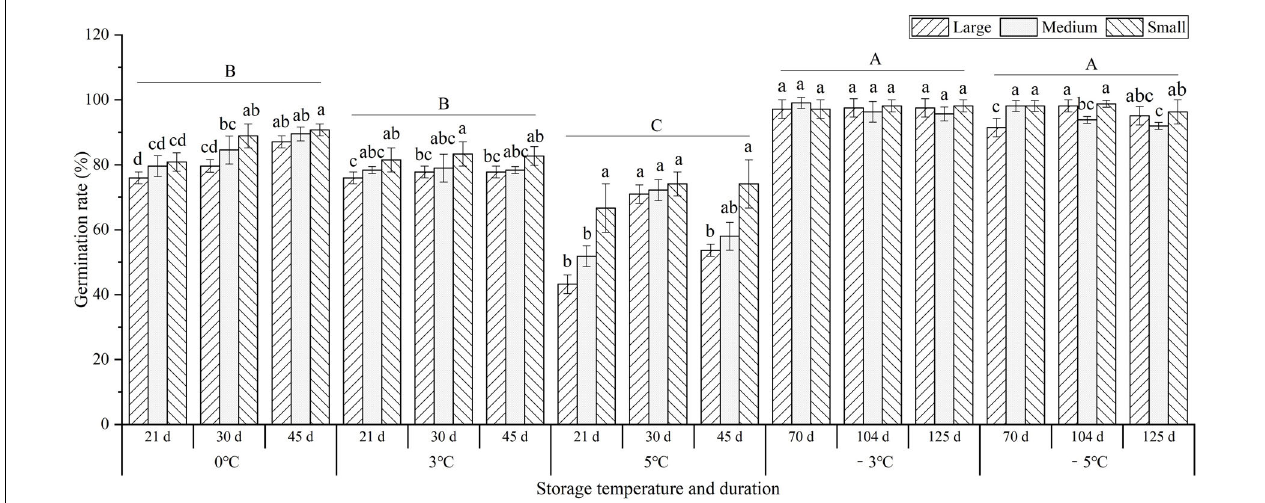
FIGURE 2 | Changes in the germination rate (GR) of seedlings at different storage temperatures and durations. Different uppercase letters represent a significant difference ( P < 0.05) in the average value of different seedlings and storage durations among different temperatures. Different lowercase letters represent a significant difference between the size treatments at different temperatures.